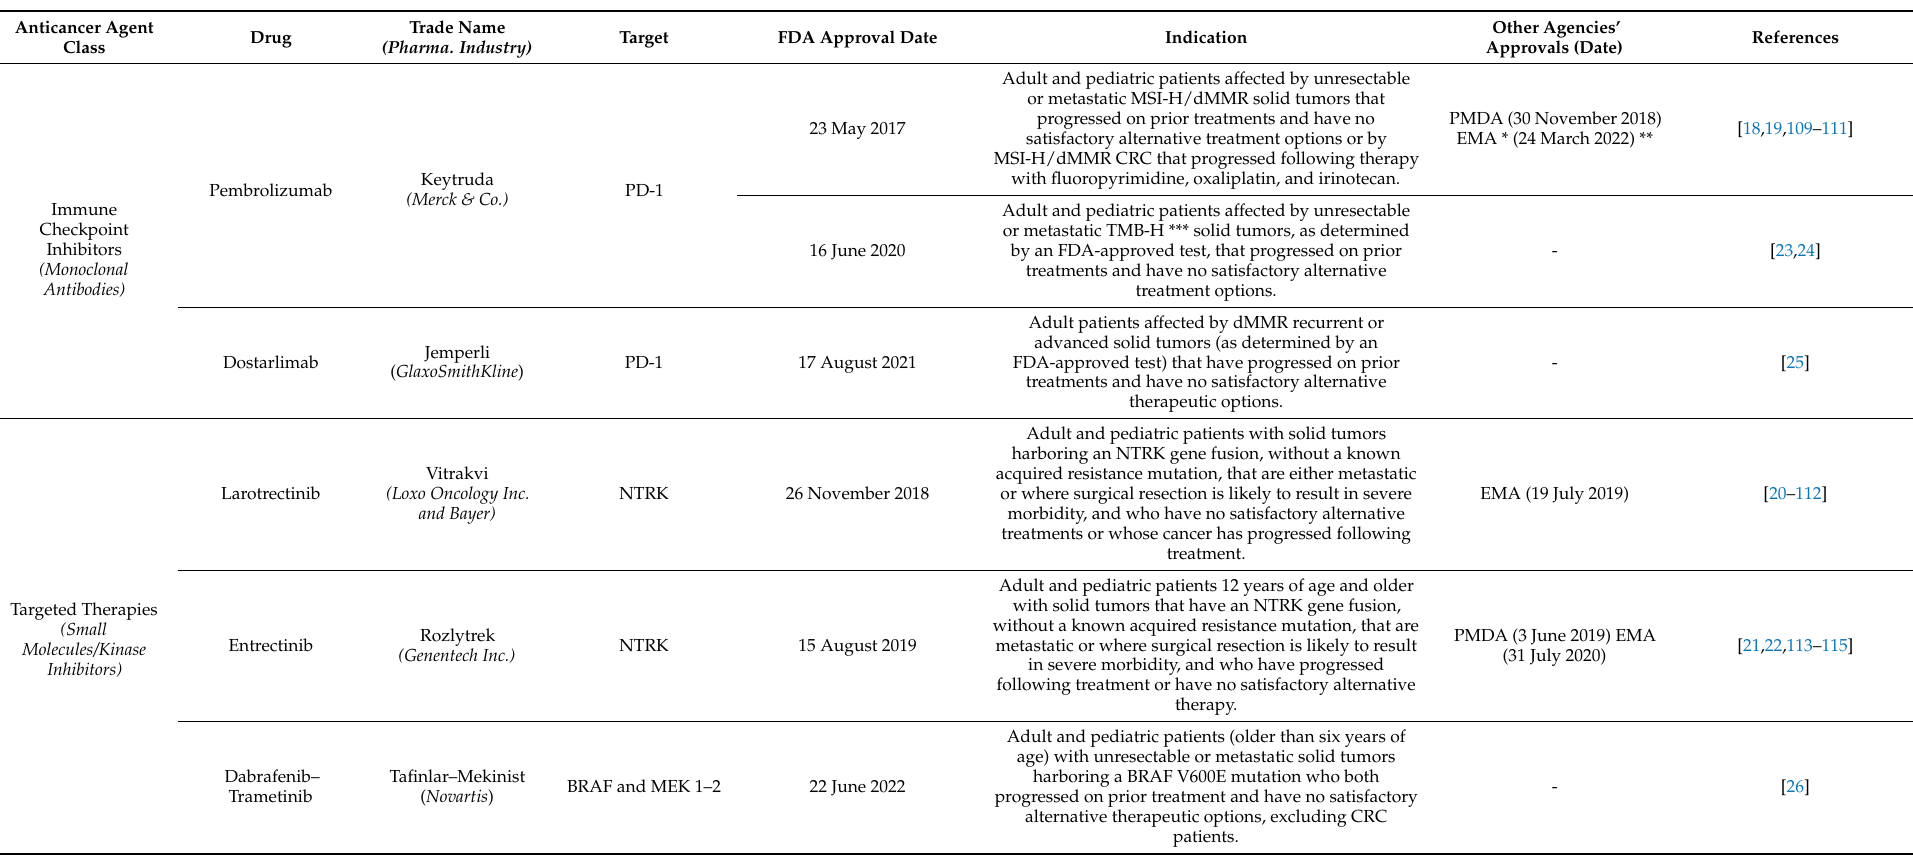
Table 4. List of FDA-approved drugs with histology-agnostic